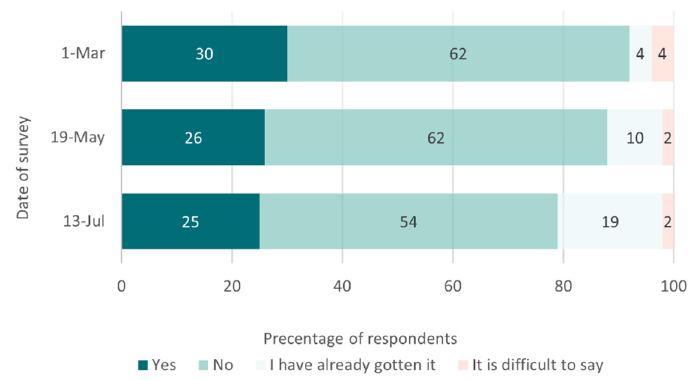
Figure 3. Willingness to receive the COVID-19 vaccine Sputnik V in Russia, evolution over time from March to July 2021 (data collected from three Levada surveys) [3,100,101].